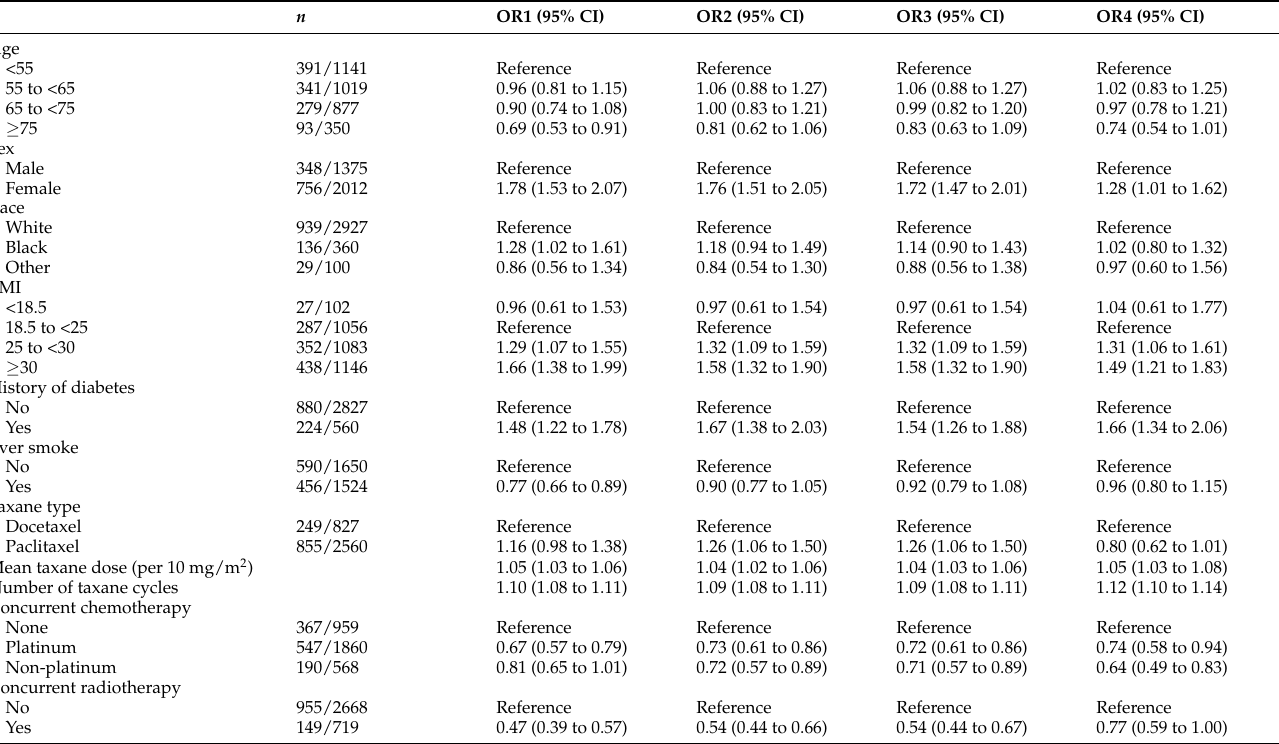
Table 2. Association of neuropathy with patient demographics and clinical